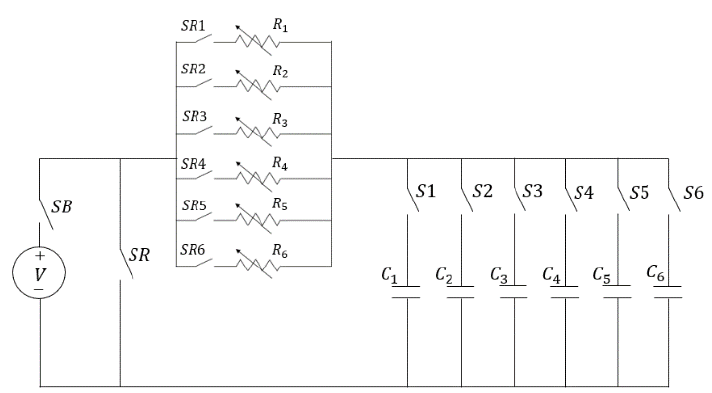
Figure 10. Schematic representation of the test bench used for ultracapacitors.